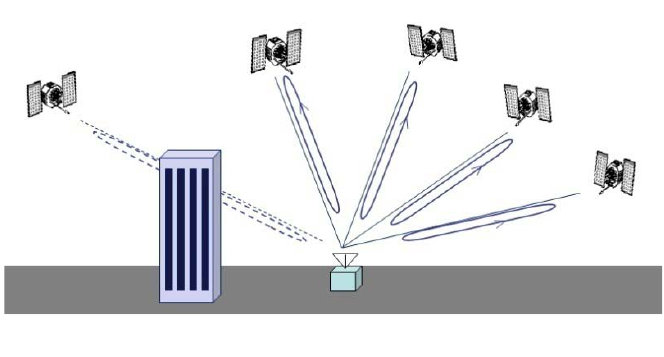
Figure 2. Vector tracking loop.